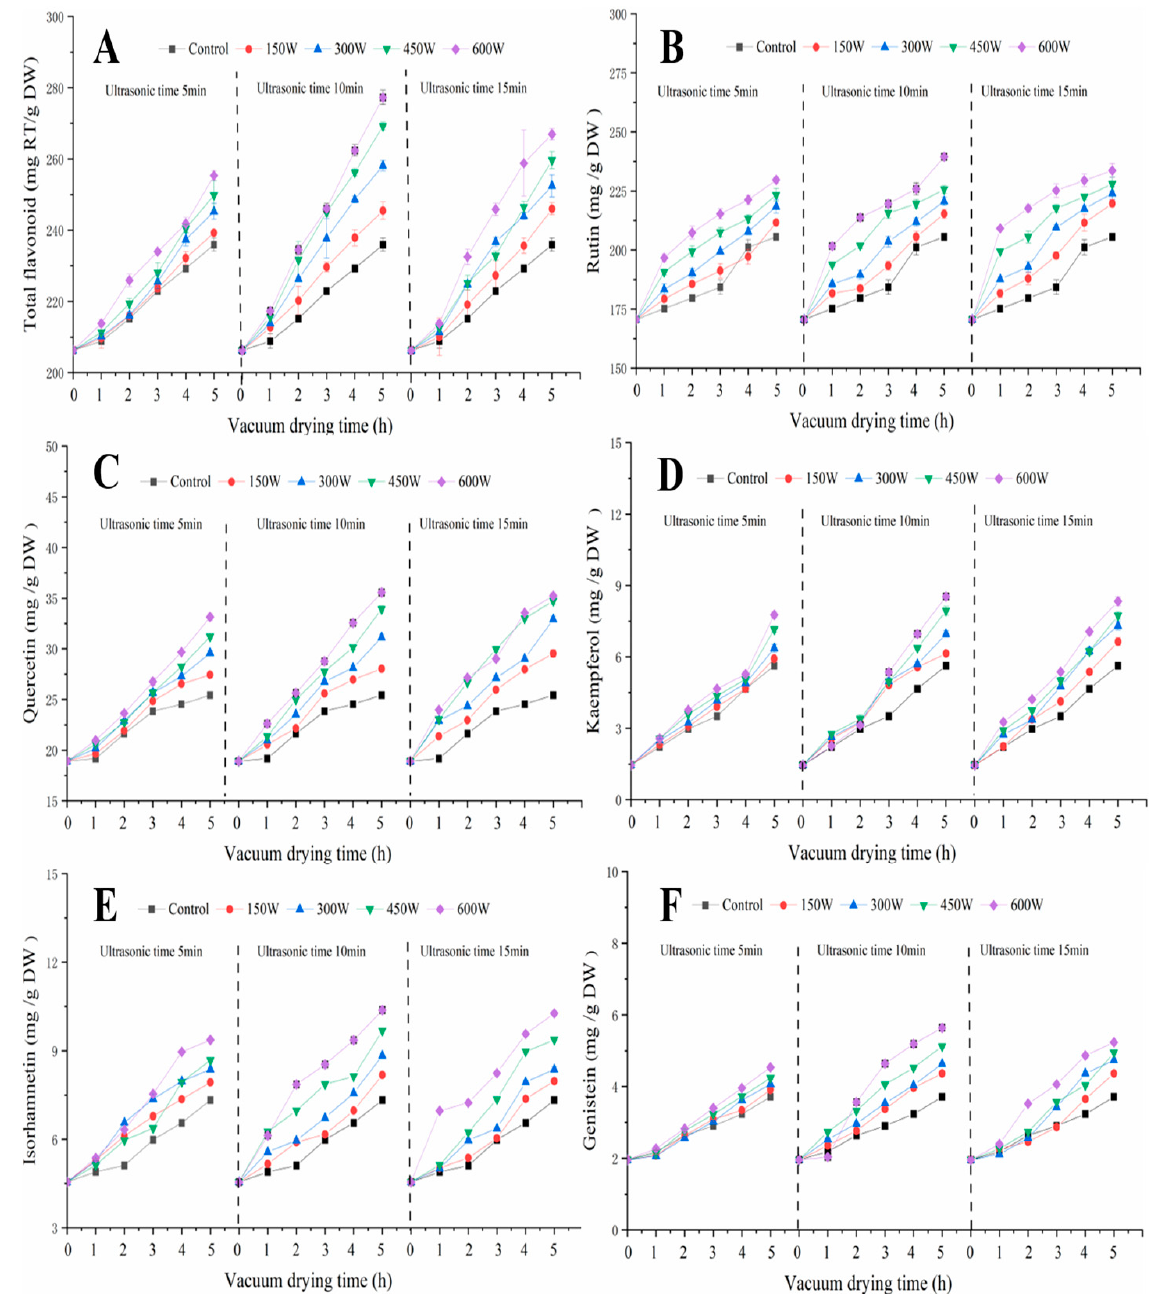
Figure 4. The effects of UAVD on the contents of total flavonoids, rutin, quercetin, kaempferol, isorhamnetin, and genistein ( A – F ) in FSI at different time durations.